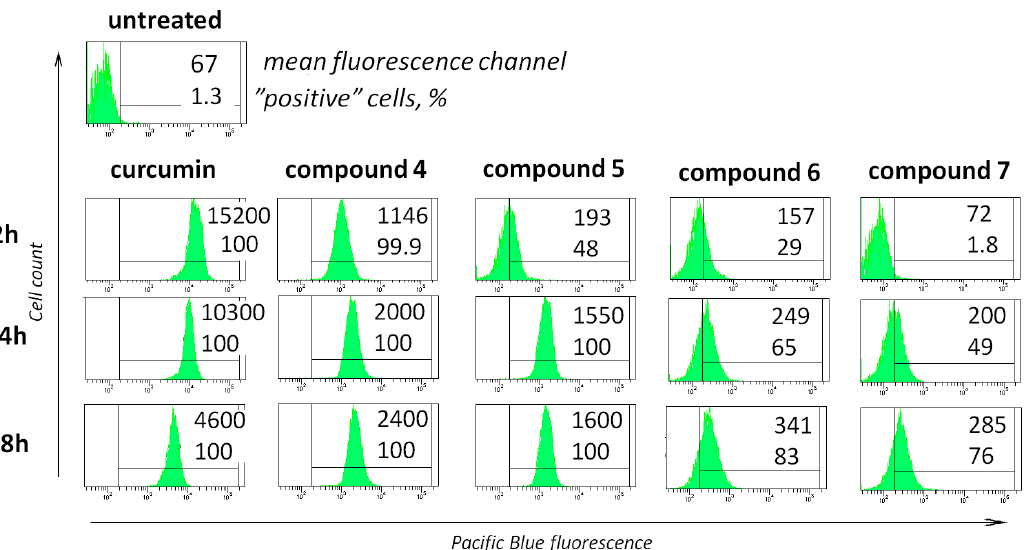
Figure 1. Intracellular accumulation of curcumin and cobalt bis(dicarbollide)—curcumin conjugates 4–7 in HCT116 colon carcinoma cells. Cells were treated with 25 µ M of curcumin or conjugates of cobalt bis(dicarbollide) with curcumin 4–7 for the indicated time intervals, washed with saline and analyzed using flow cytometry. Percentage of “positive cells” and values of mean fluorescence channel were calculated from the respective histograms. One representative experiment out of three with similar results is shown.